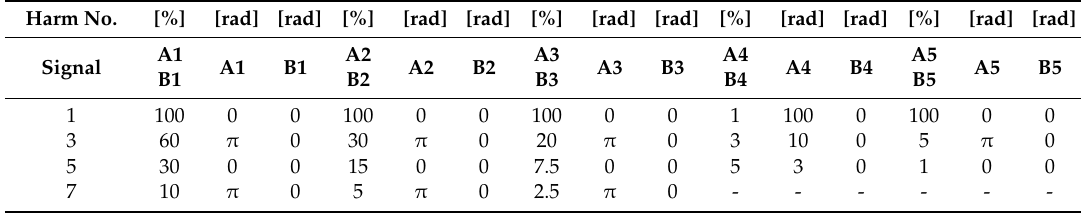
Table 3. Input signals parameters (harmonic’s amplitudes and